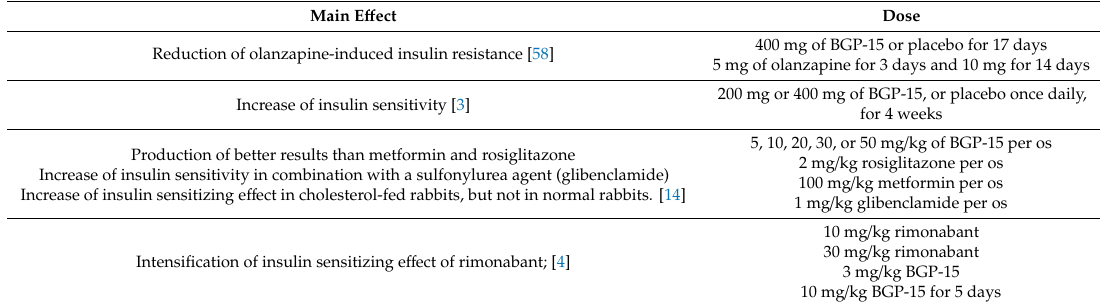
Table 6. Summary of the investigations related to the insulin sensitizing e ff ect of BGP-15. Main E ff ect Dose Reduction of olanzapine-induced insulin resistance [58] 400 mg of BGP-15 or placebo for 17 days 5 mg of olanzapine for 3 days and 10 mg for 14 days 200 mg or 400 mg of BGP-15, or placebo once daily, Increase of insulin sensitivity [3] for 4 weeks 5, 10, 20, 30, or 50 mg / kg of BGP-15 per os Production of better results than metformin and rosiglitazone 2 mg / kg rosiglitazone per os Increase of insulin sensitivity in combination with a sulfonylurea agent (glibenclamide) Increase of insulin sensitizing e ff ect in cholesterol-fed rabbits, but not in normal rabbits. [14] Intensification of insulin sensitizing e ff ect of rimonabant; [4]